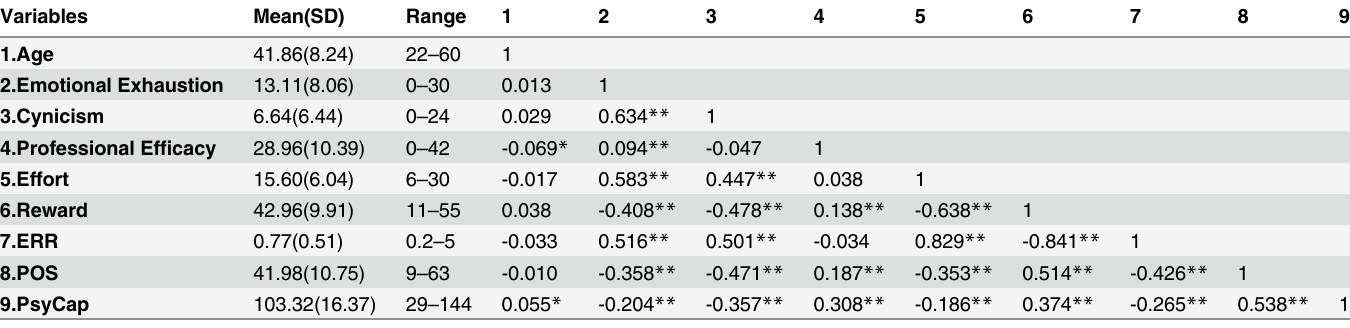
Table 2. Means, standard deviations (SD), range, and correlations of continuous